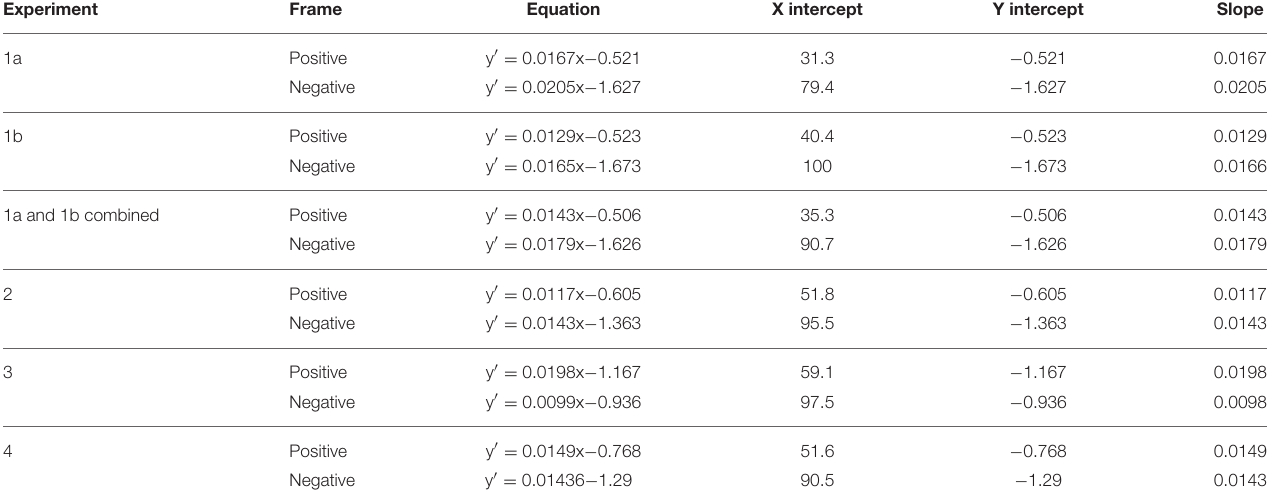
TABLE 2 | Descriptive Statistics for Experiments 1a, 1b, 2, 3, and 4.